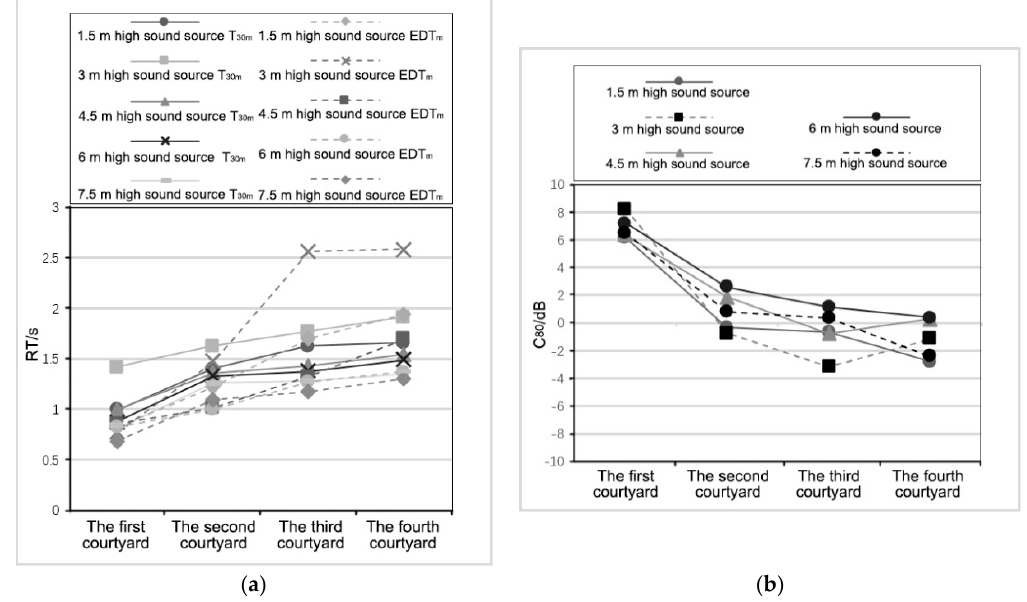
Figure 10. Diagrams of the e ff ects of bell tower height on courtyard sound fields. ( a ) Variation in RT. ( b ) Variation in C 80